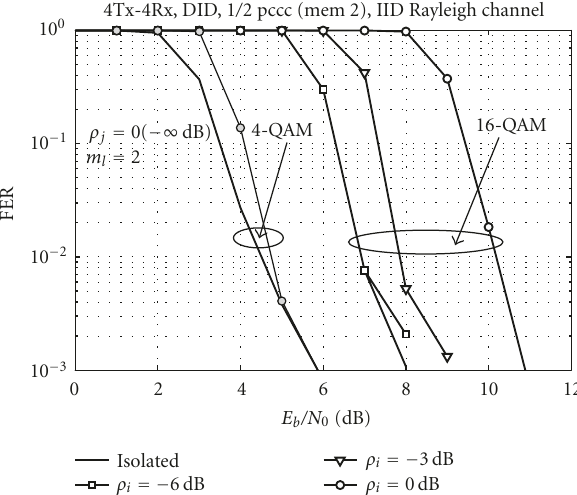
Figure 12: E ff ect of path loss of the dominant interferer ρ i for di ff erent modulation orders. Each BS sees just two dominant signals m l = 2.